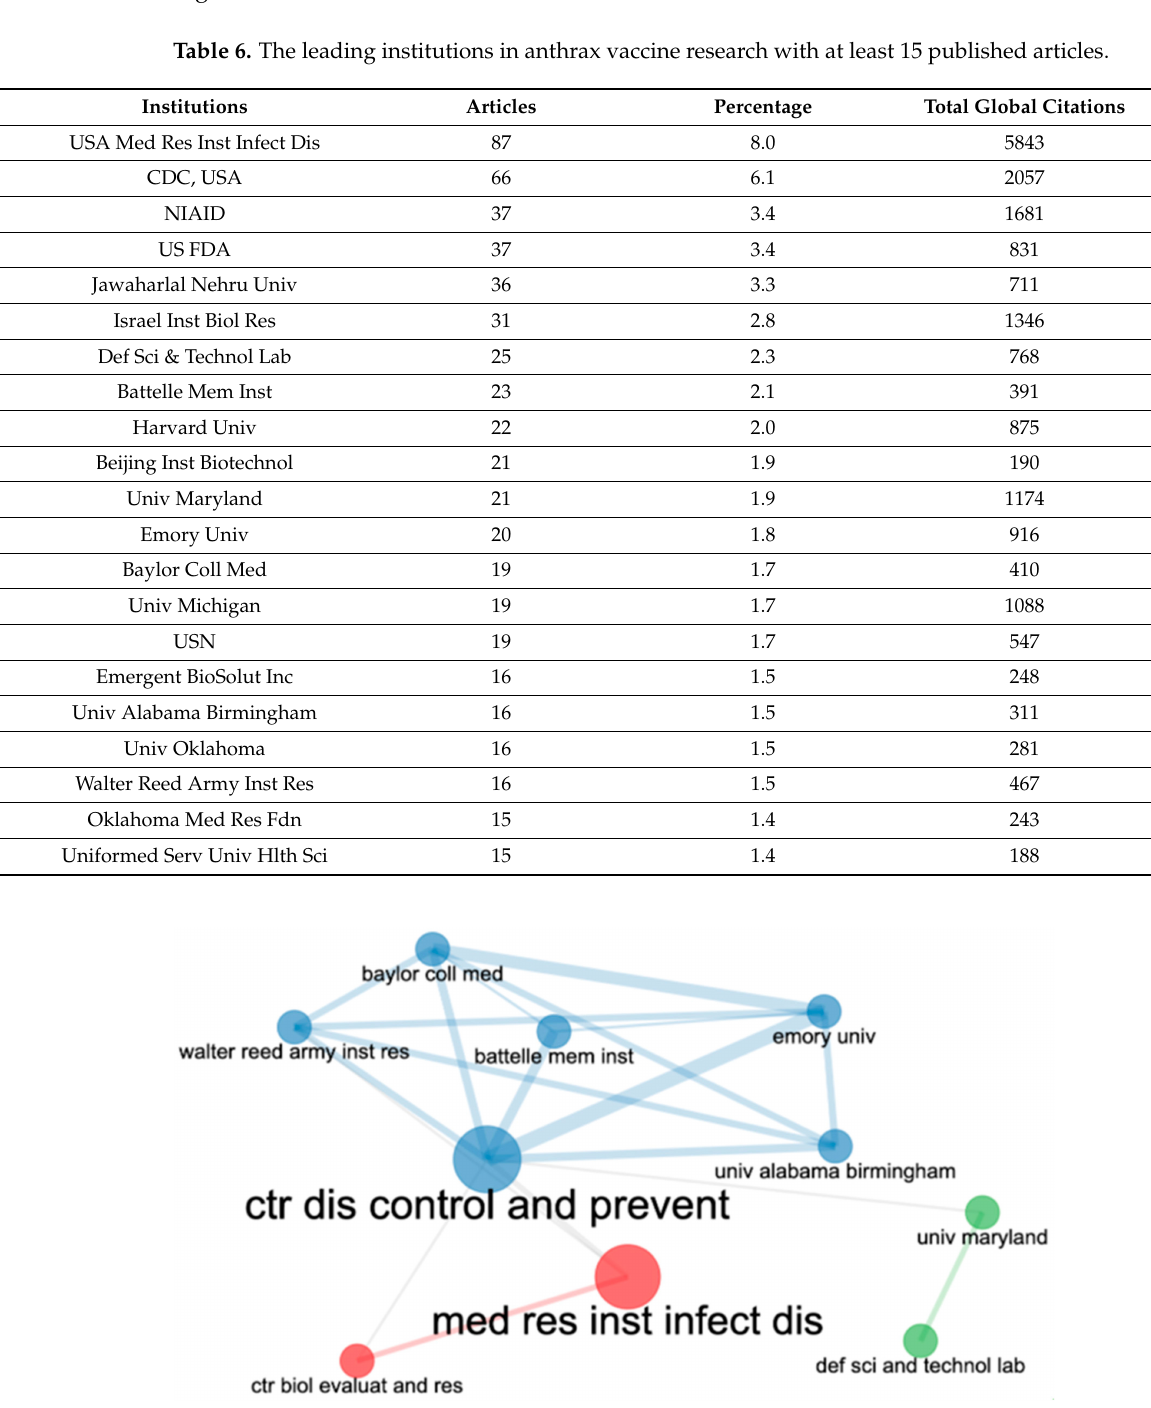
Figure 4. Mapping of the top 10 leading collaborating institutions in anthrax vaccine research between 1991 and